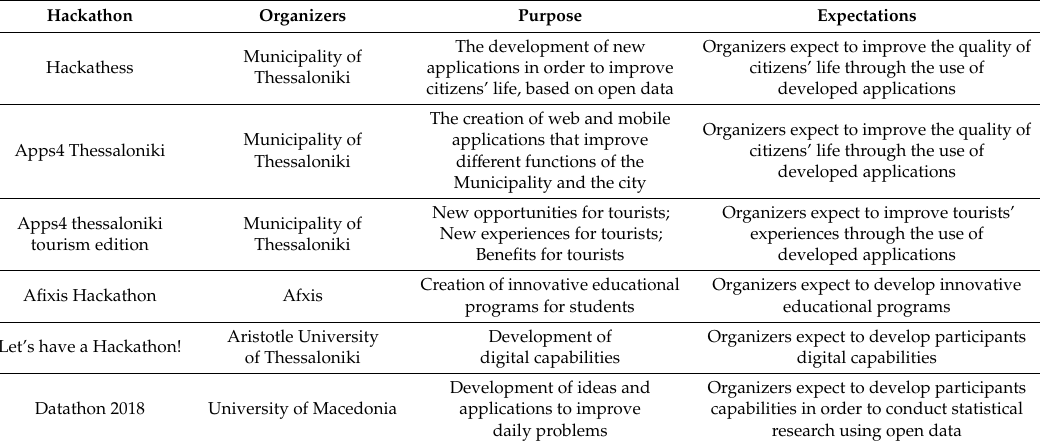
Table 1. Overview of open data hackathons and digital innovation